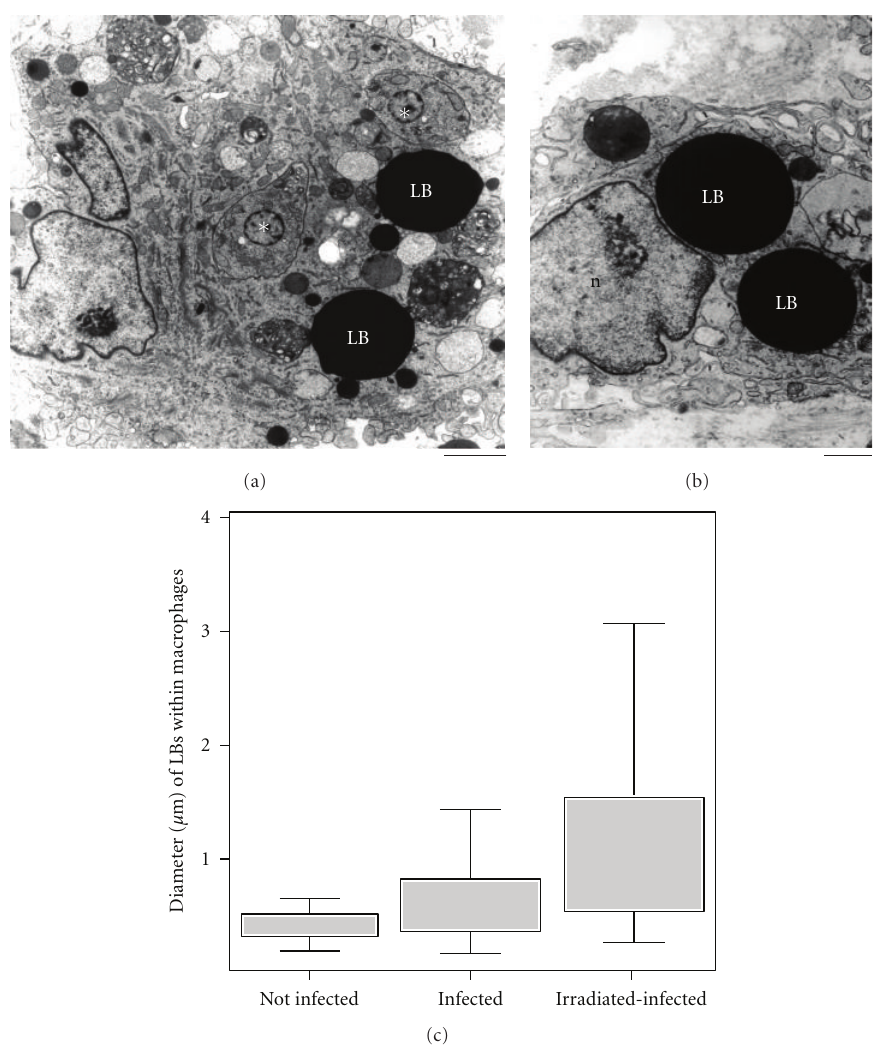
Figure 4: Lipid bodies (LB) within heart inflammatory macrophages increase in size in response to acute Trypanosoma cruzi infection and parasite load. (a) Strongly electron dense LBs from an infected animal are observed in the cytoplasm n conjunction with free amastigote forms of the parasite (asterisks). In (b), a giant LB is seen close to the nucleus in an irradiated-infected rat. (c) LB diameter variation in di ff erent groups. A significant increase of LB occurred in infected alone compared to uninfected and in irradiated-infected compared to infected alone groups ( P < 0 . 05). Before infection, rats were irradiated or not and heart samples processed for transmission electron microscopy at day 12 of infection. Scale bar, 1.0 μ m (a); 600 nm (b). Reprinted from [29] with